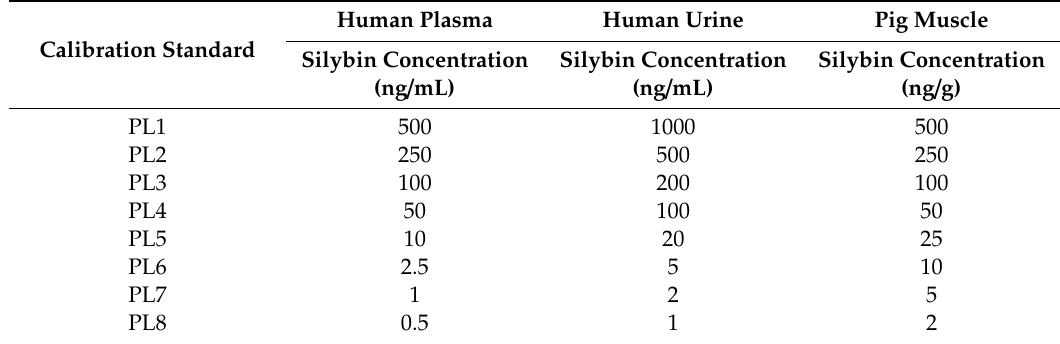
Table 3. Calibration standards and corresponding concentrations of silybin used in human plasma, human urine and pig muscle analyses.